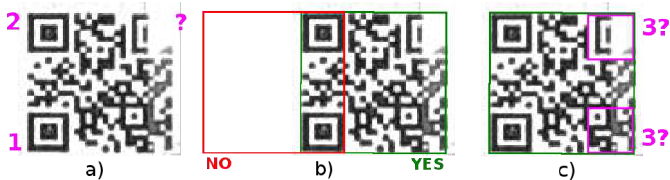
Figure 10. QR Code with one damaged Finder Pattern: ( a ) two known Finder Patterns; ( b ) two possible regions of QR Code; ( c ) two possible positions of 3rd Finder Pattern